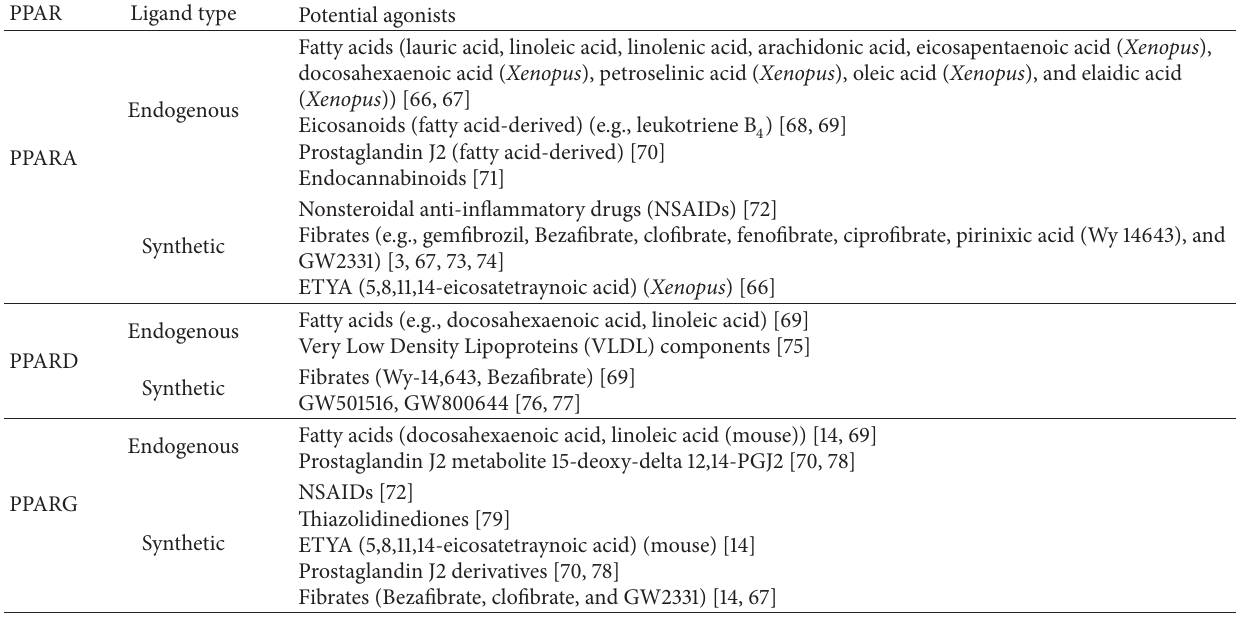
Table 1: Endogenous and synthetic ligands of vertebrate